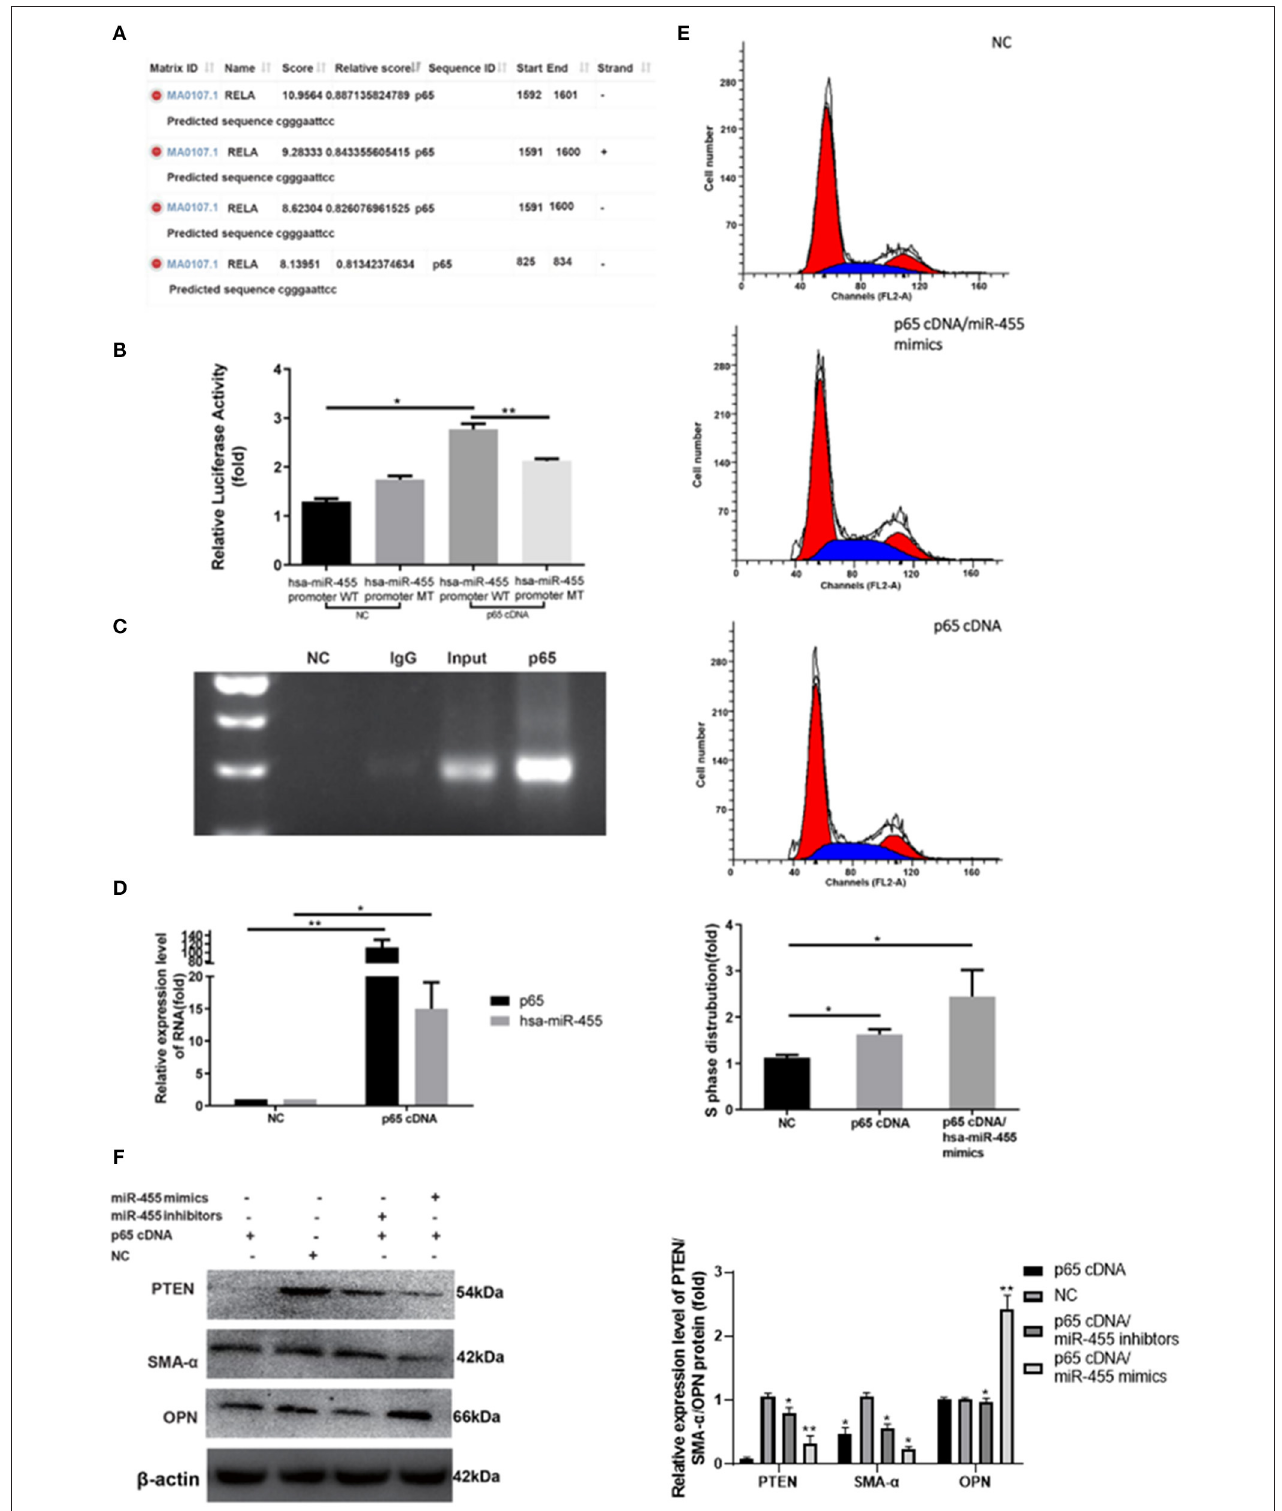
FIGURE 4 | (A) Potential binding sites between p65 and precursor hsa-miR-455 promoter regions predicted by JASPAR. (B) Dual-luciferase assays showing p65 cDNA transfection upregulating luciferase activity with co-transfection of wild-type precursor hsa-miR-455 promoter region containing luciferase reporter vector,